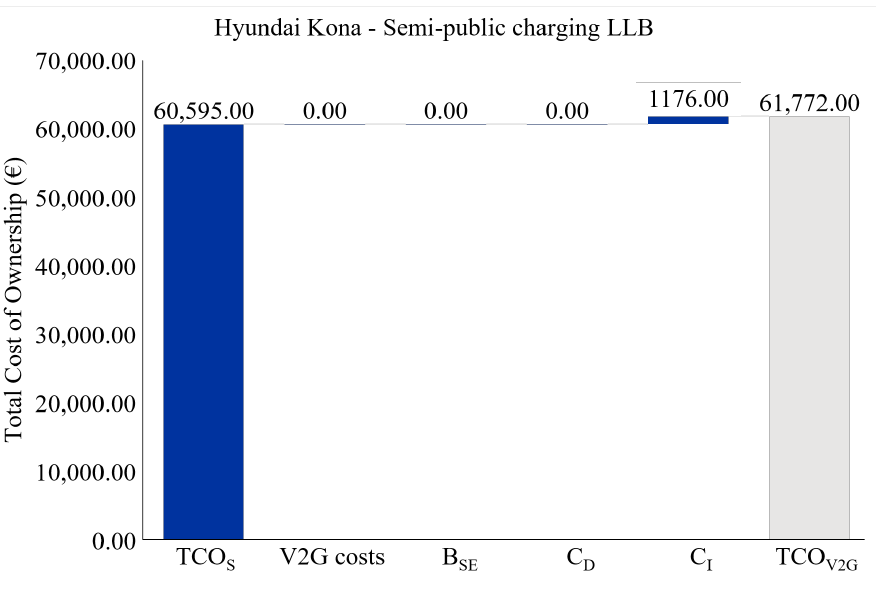
Figure A9. Standard and V2G TCO of a Hyundai Kona in a semi-public charging case providing LLB ( TCO S = Standard TCO, B SE = benefit of saved electricity costs from the grid, C D = direct compensation, C I = indirect compensation, TCO V 2 G = V2G TCO); source: own